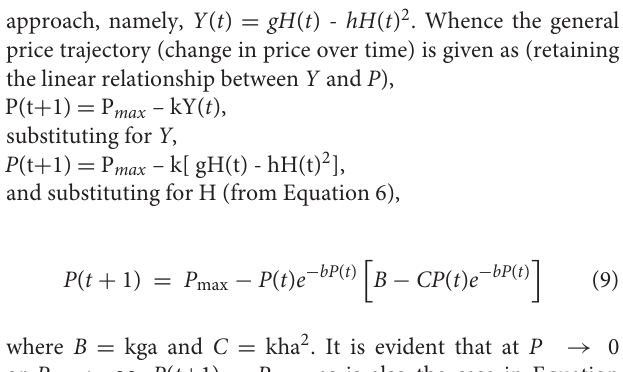
0.24, a 12, h 0.057. (C) b = = =